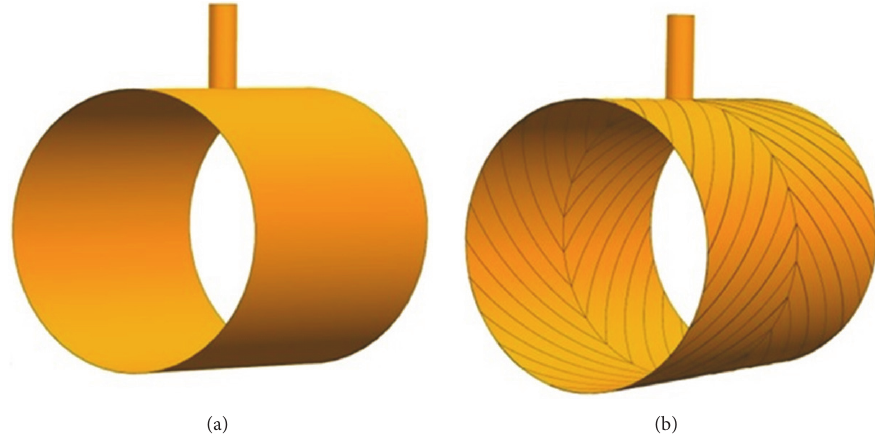
Figure 2: (a) The plain gas film model; (b) the herringbone groove gas film model.